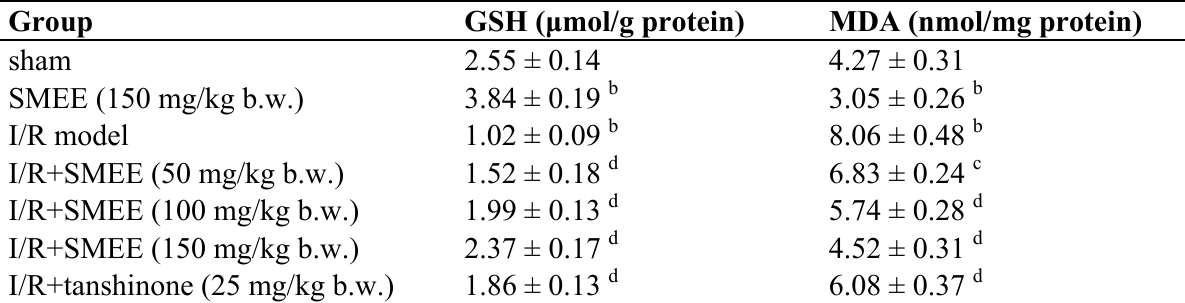
Table 2. Effect of Salvia miltiorrhiza ethanol extract pretreatment on renal MDA level in